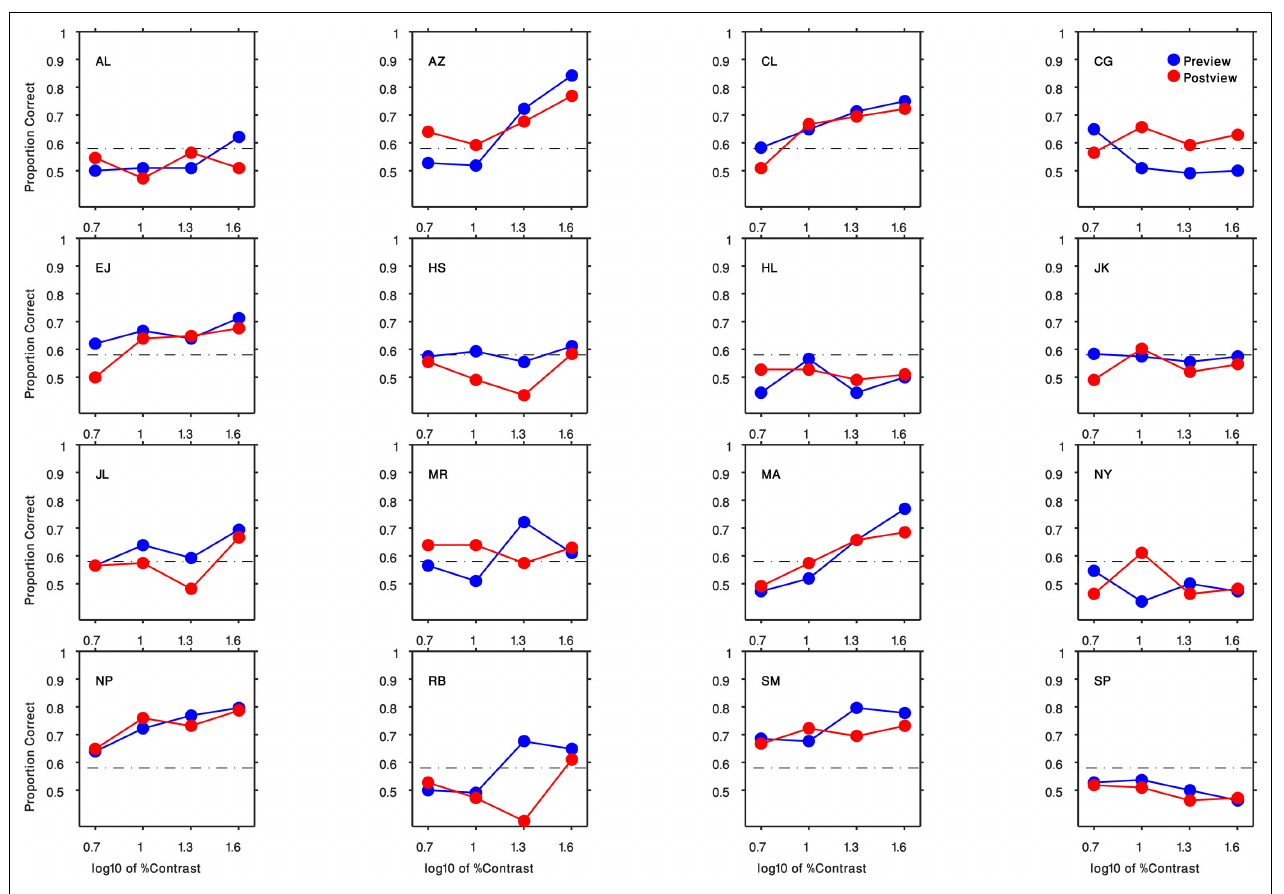
FIGURE 3 | Results of Experiment 1 for all 16 participants. Each panel indicates the result of an observer (initials indicated in the top left corner).The preview condition is shown in blue circles and the post-view condition is shown in red circles. Horizontal axis is the log 10 of the gabor patch percent